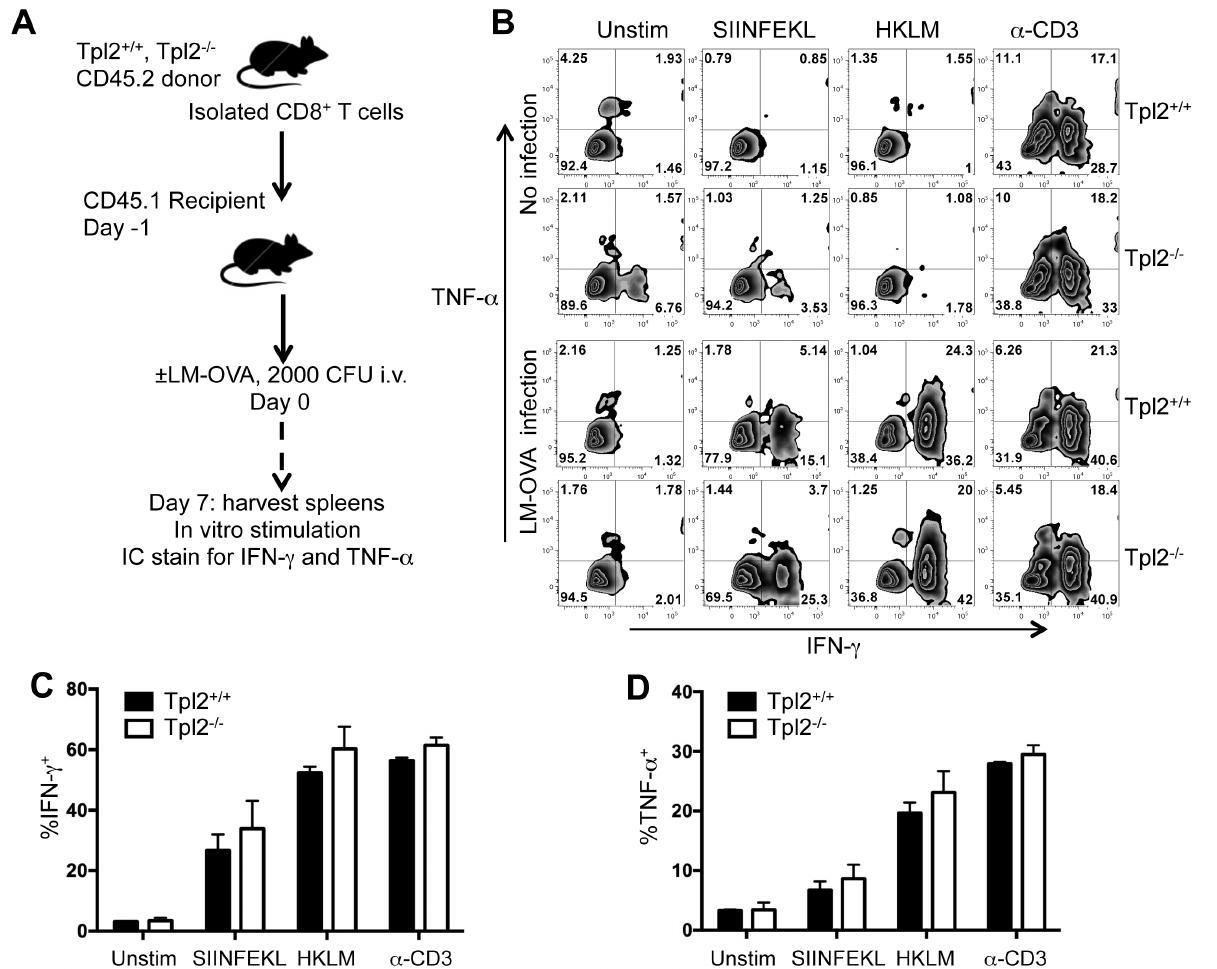
Figure 3. L.monocytogenesinfectionprimescytokineexpressioninTpl2-defecientCTLs . (A) Total CD8 + T cells were isolated from Tpl2 + / + (n=4) and Tpl2 2 / 2 (n=4) mice, which carried the CD45.2 congenic marker. Isolated cells from each mouse were separately injected into three CD45.1 recipient mice at 1e 6 cells per mouse, intravenously on day -1. On day 0 mice were either infected with 2000 CFU of LM-OVA or left uninfected. Spleens were harvested day 7 post infection and splenocytes were cultured with SIINFEKL (10 nM), HKLM (5 mg/mL), soluble anti-CD3 (0.5 m g/mL), or left unstimulated for 18 h. Monensin was added to the cultures for the last 6 h. Intracellular expression of IFN- c and TNF- a were measured by flow cytometry along with the surface markers CD8a and CD45.2. (B) Intracellular IFN- c (x-axis) and TNF- a (y-axis) expression after 2 u stimulation is represented in dot plots for both Tpl2 + / + and Tpl2 2 / 2 mice. Transferred cells were identified based on positive staining for CD8 a and CD45.2 surface marker. (C–D) Total IFN- c (C) and TNF- a (D) expressing cells were quantified as a percentage of the identified total transferred (CD8 + CD45.2 + ) T cells. Mean 6 SEM is plotted representing triplicate donor mice with Tpl2 + / + in black and Tpl2 2 / 2 in white bars. No statistically significant differences in cytokine expression were observed between strains as assessed by two-way ANOVA.